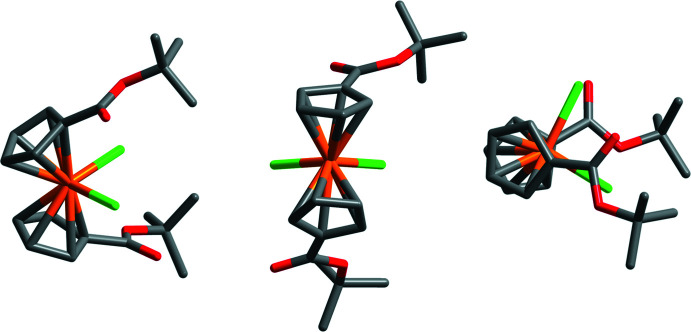
Ligand orientation in the structure of t-BuOOCCp2TiCl2.